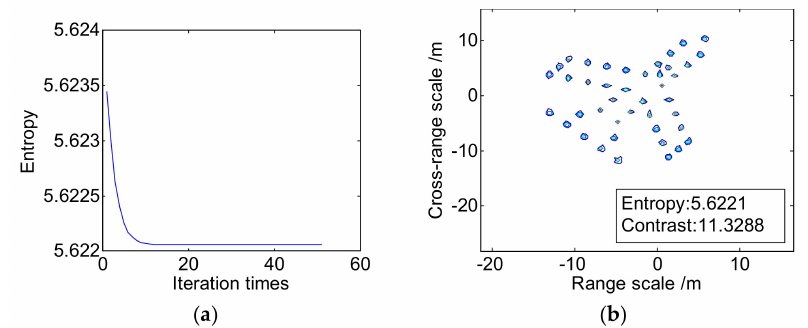
Figure 6. Search for the optimal RAA and ISAR image through the gradient descent optimization. ( a ) Entropy change of ISAR image during iteration; ( b ) optimal ISAR image based on optimized non-uniform rotation